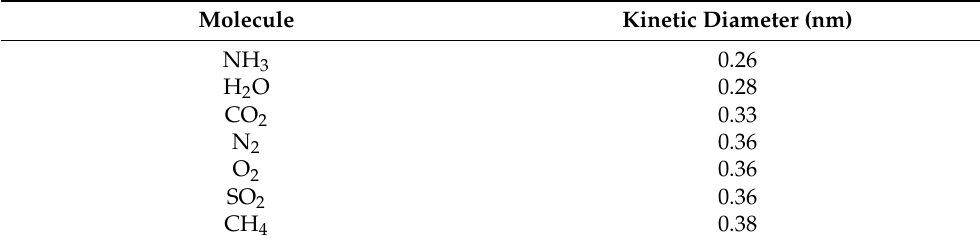
Table 2. Kinetic diameter for various molecules